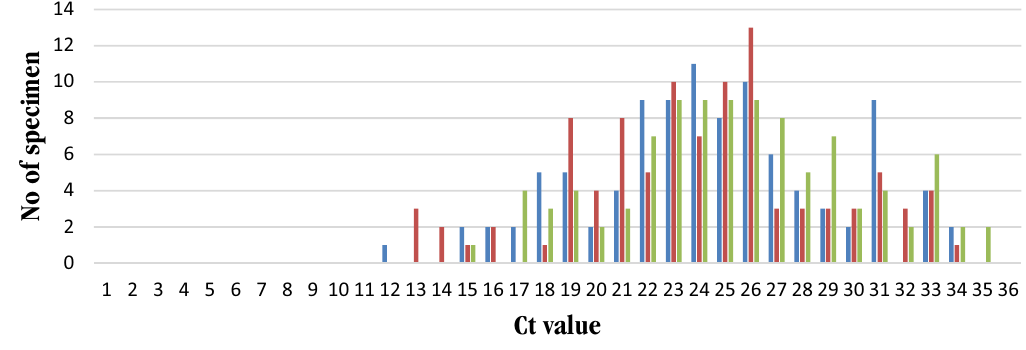
Figure 13. Distribution of experimentally obtained C t values for the 100 positive specimen for Target 1, Target 2, and Target 3 are plotted. Only 2/100 (2%) positive sample were found with C t values slightly higher than LoD or near the assay LoD and as such the sensitivity of detection may be less than 100%. Remaining 98 specimens showed efficient detection of the entire three